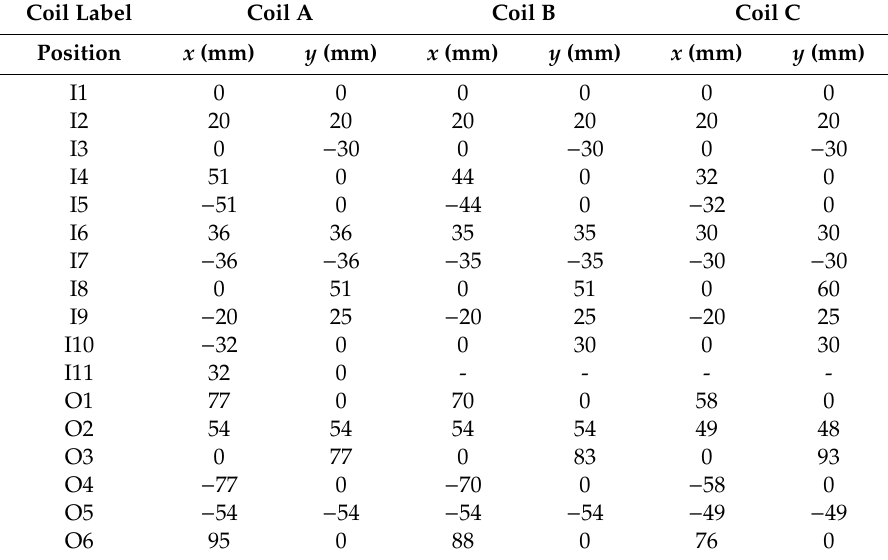
Table 2. Location information of the holes of the fixed plates.